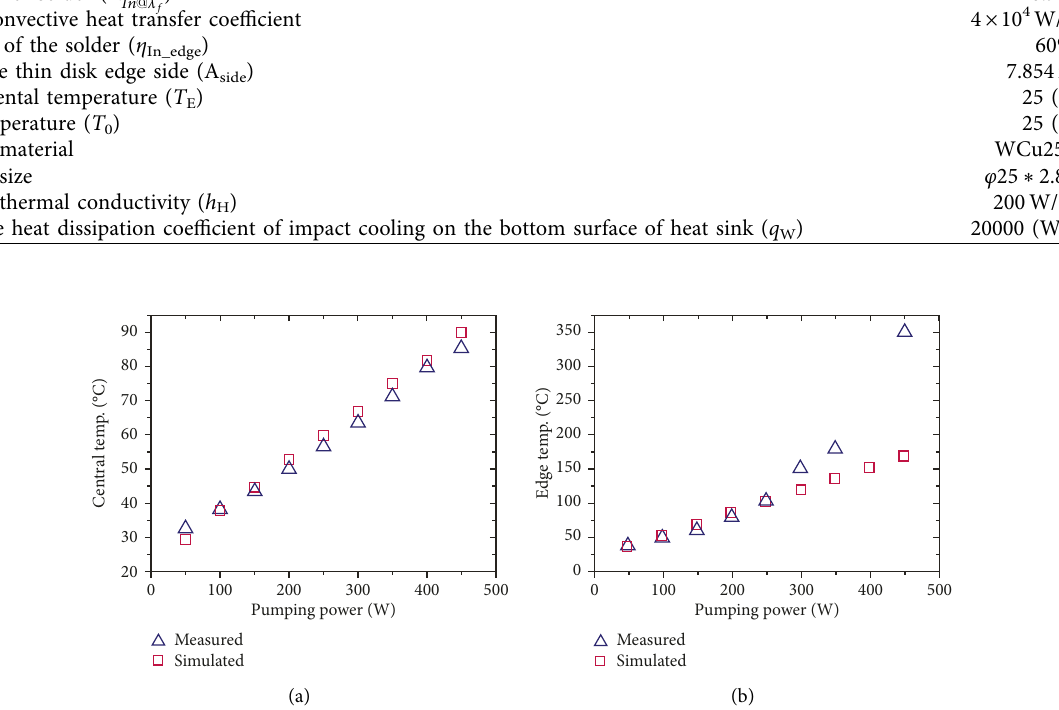
Figure 7: The simulated and measured temperature of (a) the central and (b) the edge of the thin disk